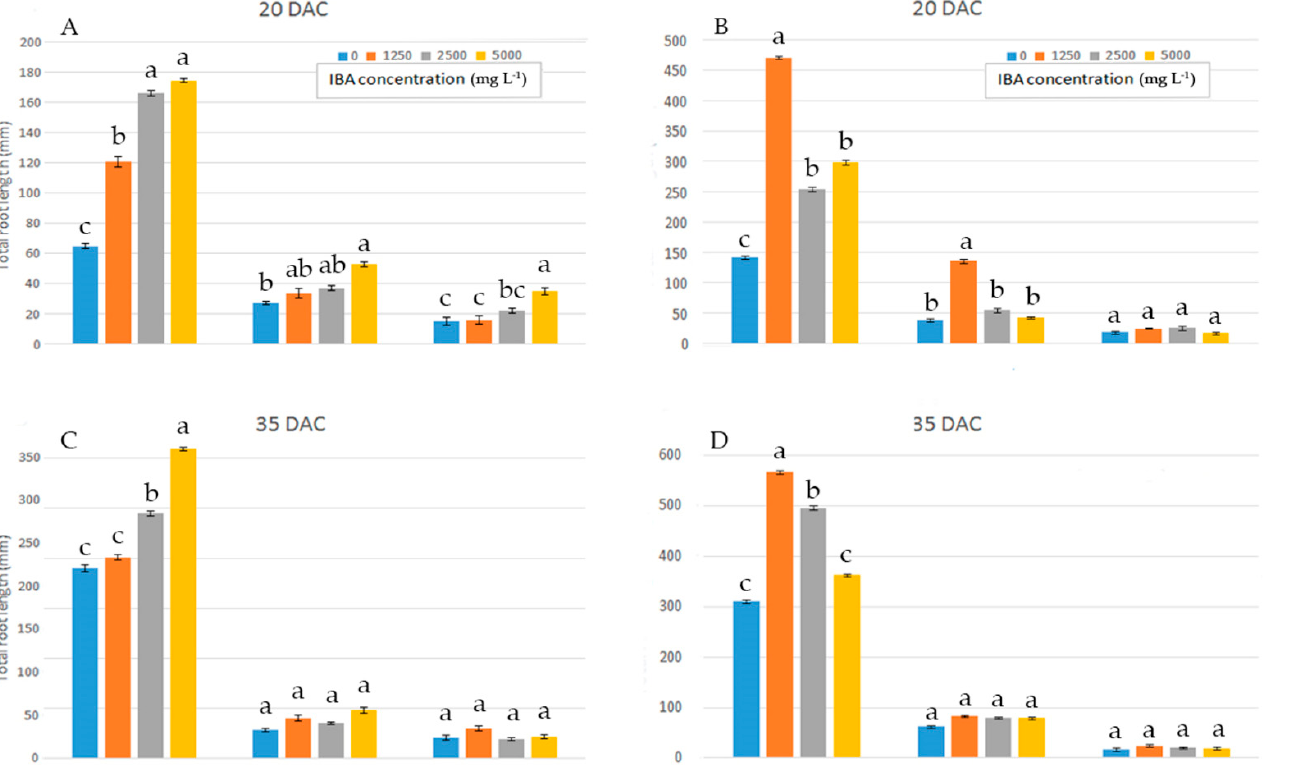
Figure 3. Total root length distribution (%) of wild sage ( A , C , E ) and glossy abelia ( B , D , F ) in three diameter classes, evaluated at three sampling dates, as effect of four IBA concentration. Vertical bars with different letters means significant differences according with S.N.K. test, p ≤ 0.05 for each class root diameter. Data shown are means ± SE of three replicates. In glossy abelia, most total root length proportions fell in the very fine (0–0.5 mm) diameter class, and distinct patterns were observed among IBA concentrations at 20 (Figure 3B), 35 (Figure 3D) and 50 DAC (Figure 3F). In the very fine (0–0.5 mm) diameter